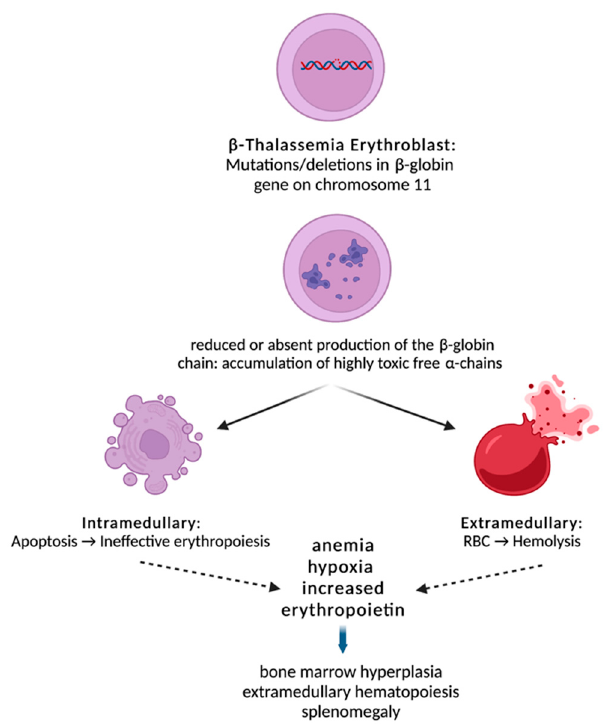
Figure 1. Beta-thalassemia is characterized by reduced or absent production of the β -globin chain due to deletions or mutations in the β -globin gene. This results in an α / β -chain imbalance and accumulation of highly toxic free α -chains leading to intramedullary apoptosis and peripheral hemolysis. Ineffective erythropoiesis in β -thalassemia leads to anemia and, subsequently, to tissue hypoxia and overexpression of EPO, which results in accumulation of early erythroid progenitors. However, the erythroid progenitor maturation process fails, and erythroblasts succumb to apoptosis. Over time, the combination of tissue hypoxia, increased EPO and ineffective erythropoiesis creates a vicious cycle that ultimately leads to a massive expansion of erythroblasts.